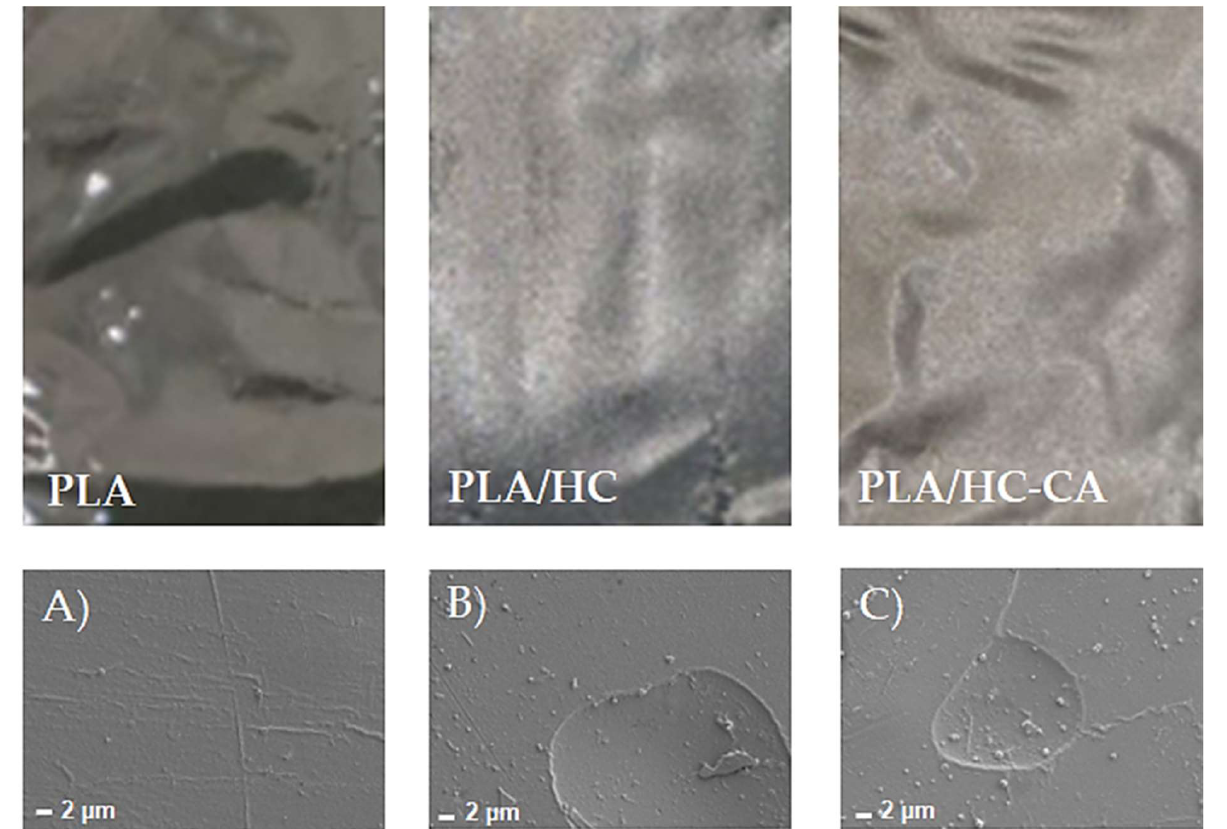
Figure 8. Representative pictures of PLA-based biocomposite films and their corresponding FE-SEM images (2000 × magnification). ( A ) FE-SEM image of PLA film; ( B ) FE-SEM image of PLA/HC film; ( C ) FE-SEM image of PLA/HC-CA film.